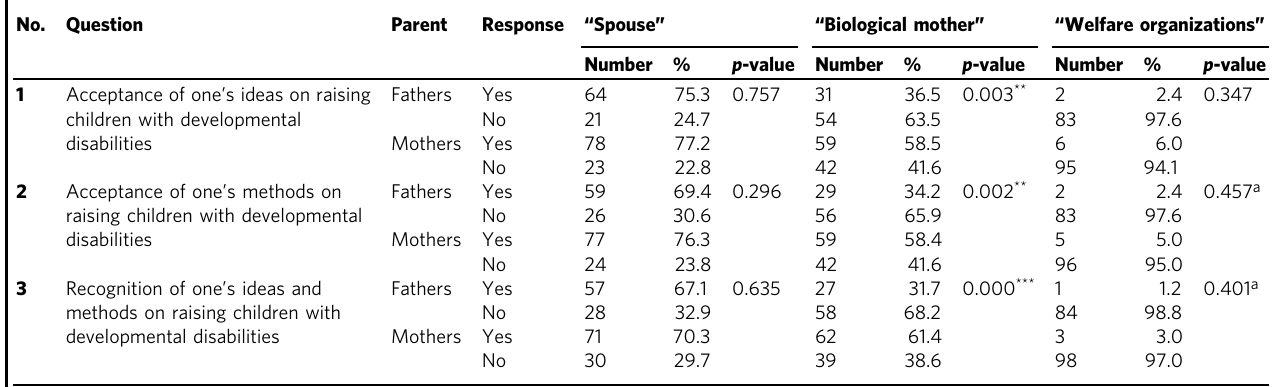
Table 6 Evaluation support survey